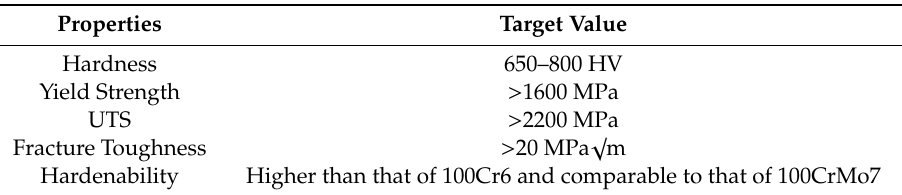
Table 1. Typical specifications for bearing steels.